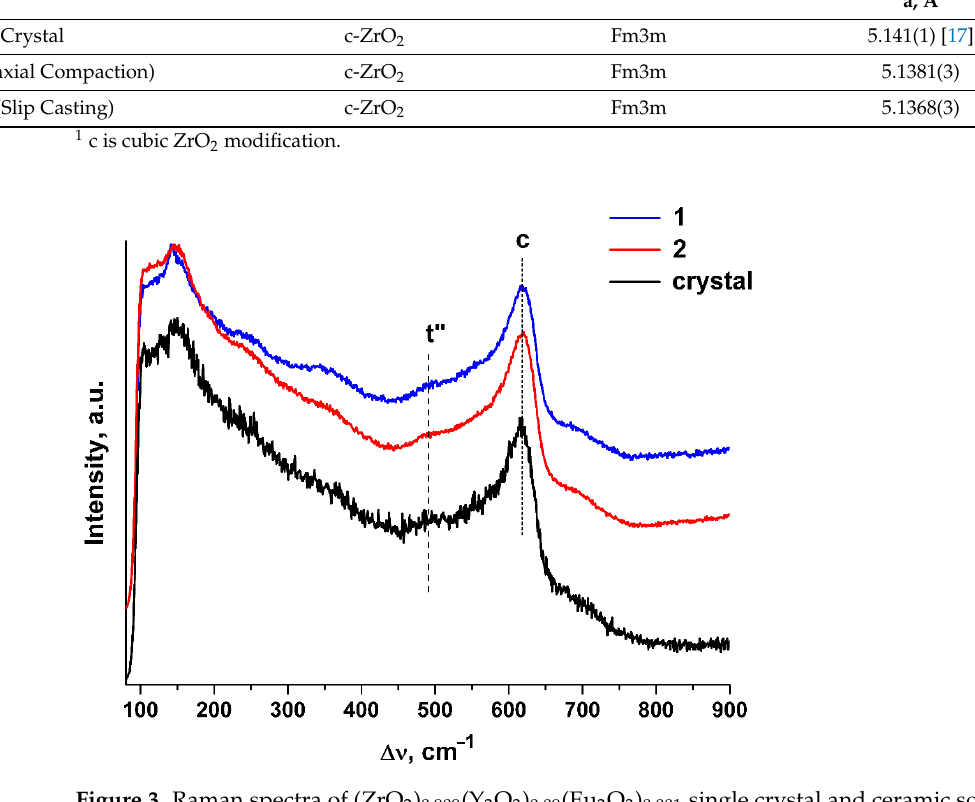
Figure 3. Raman spectra of (ZrO 2 ) 0.909 (Y 2 O 3 ) 0.09 (Eu 2 O 3 ) 0.001 single crystal and ceramic solid solutions synthesized using different methods from crushed single crystals: (1) uniaxial compaction; (2) slip casting. λ exc. = 632.8 nm, Т = 300 K. (2) slip casting. λ exc. = 632.8 nm, T = 300